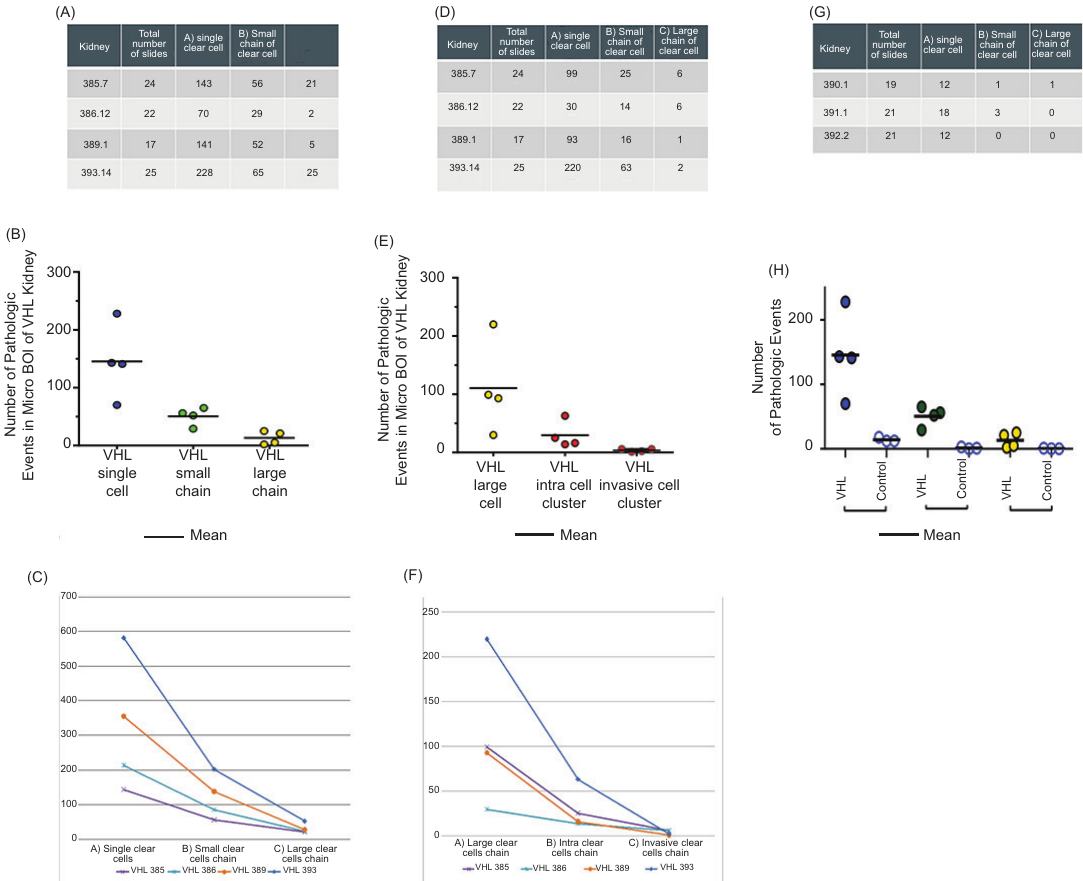
Figure 5: Numbers of pathologic events in micro-BOIs (left, A-C) and BOIs (middle, D-F) in VHL kidneys and control kidneys. Control results are only shown for micro-BOI counts (right, G, H); control results were consistently negative for large chains, intratubular clear cell clusters or invasive clusters. In all blocks, lower complexity events numerically exceed consecutive events of higher